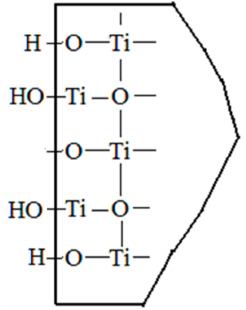
Figure 10. Hydroxylation on the surface of TiO 2.